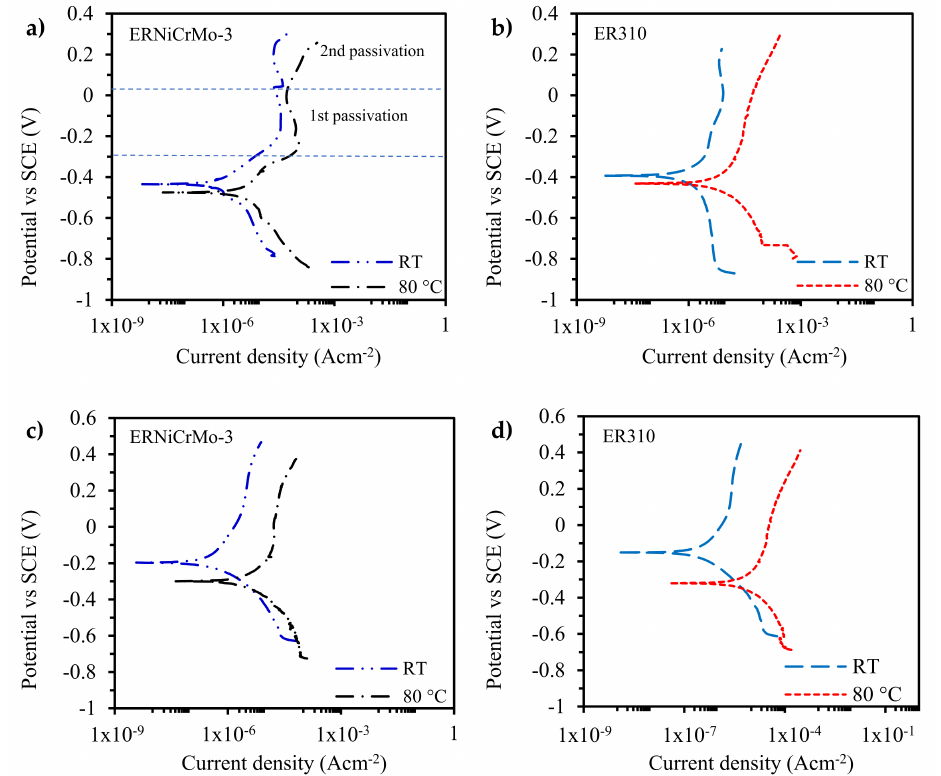
Figure 13. The polarization curves of the IN600 joints in ( a , b ) NaOH and ( c , d ) Na 2 S 2 O 3